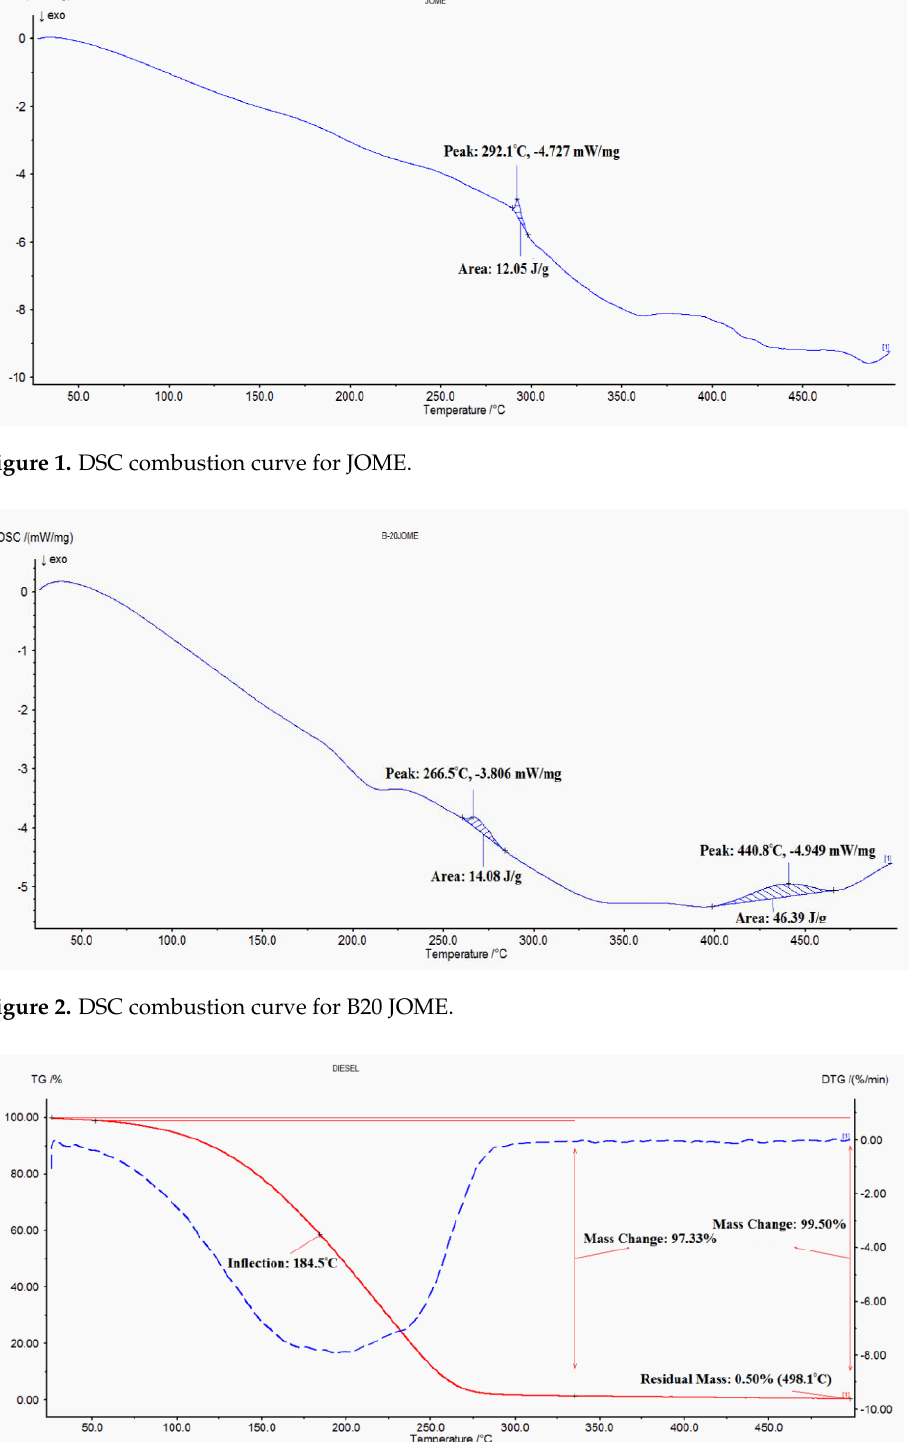
Figure 3. TG-DTG curve for diesel.